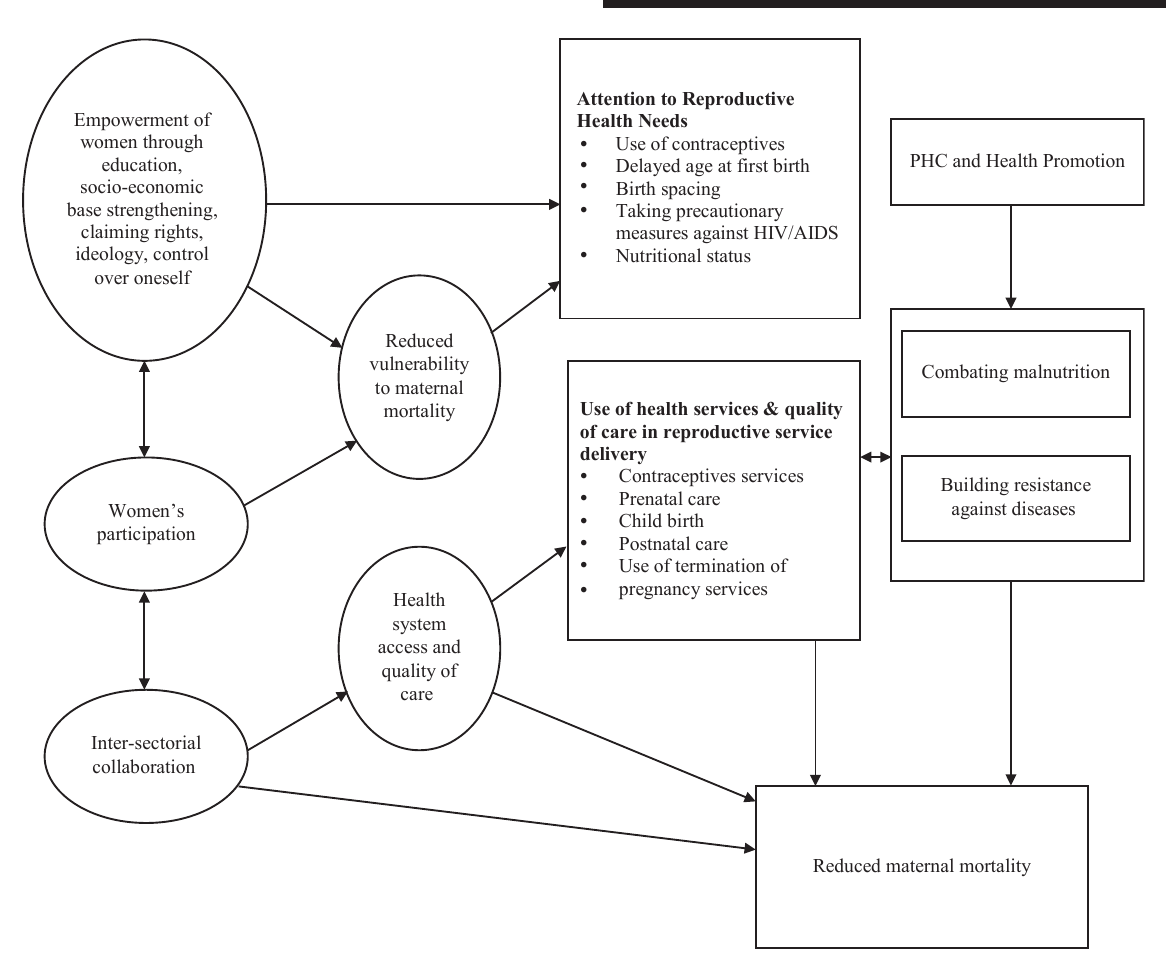
Figure 1. Model to reduce maternal mortality in South Africa 2018. Adapted from Mmusi-Phetoe.